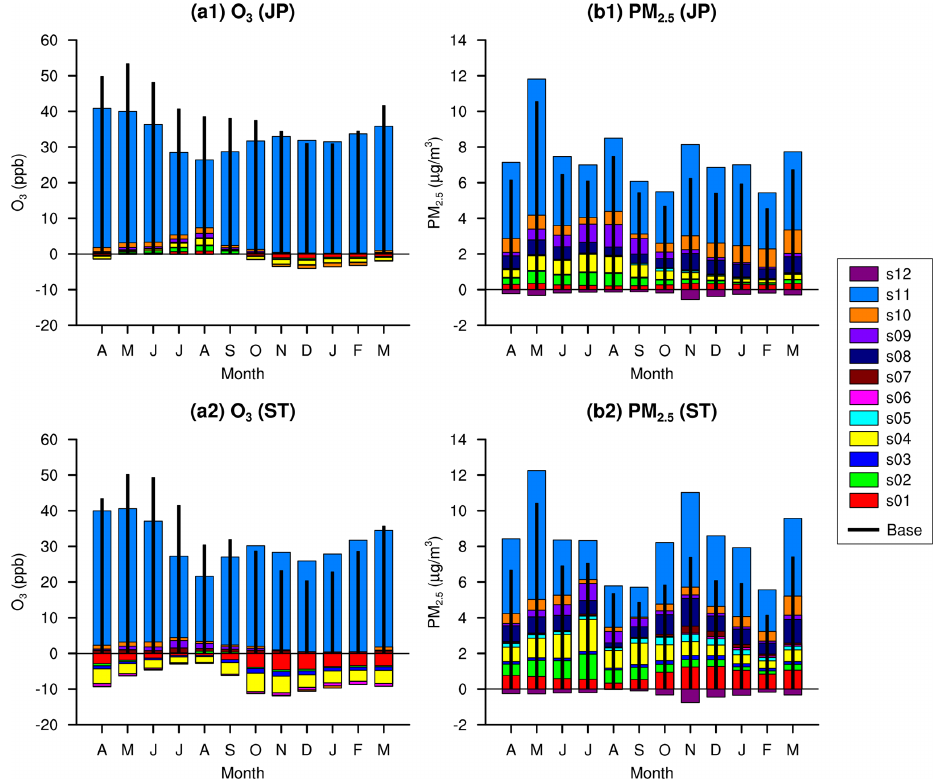
Figure 3. Source sensitivities of the monthly mean ozone and PM 2 . 5 concentrations derived by BFM in all of Japan (JP) and ST. Thick black lines represent the simulated